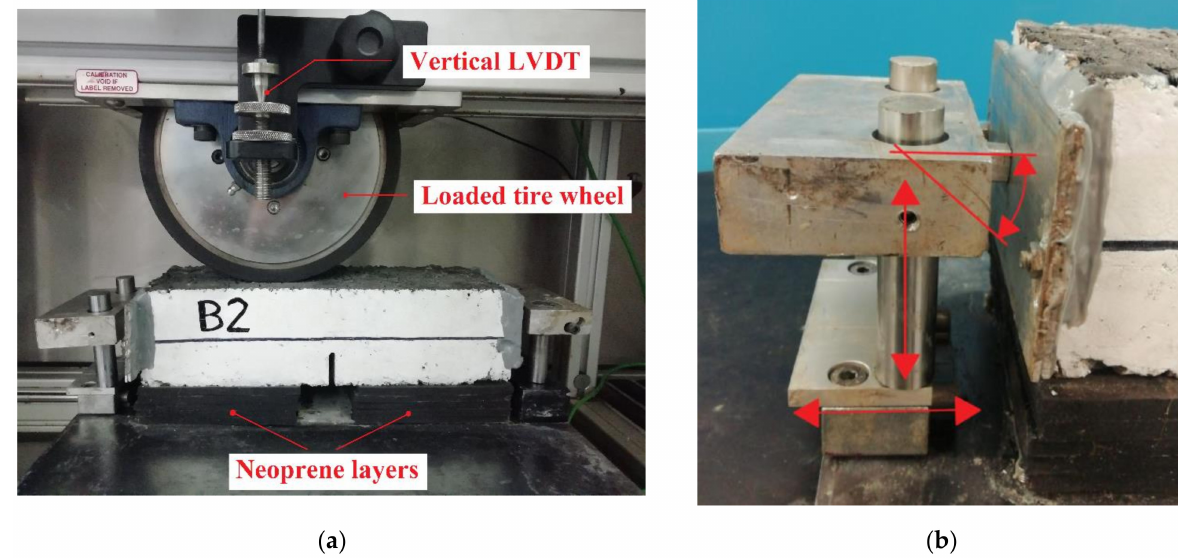
Figure 3. Reflective cracking test: testing setup ( a ), detail of the lateral support ( b ).